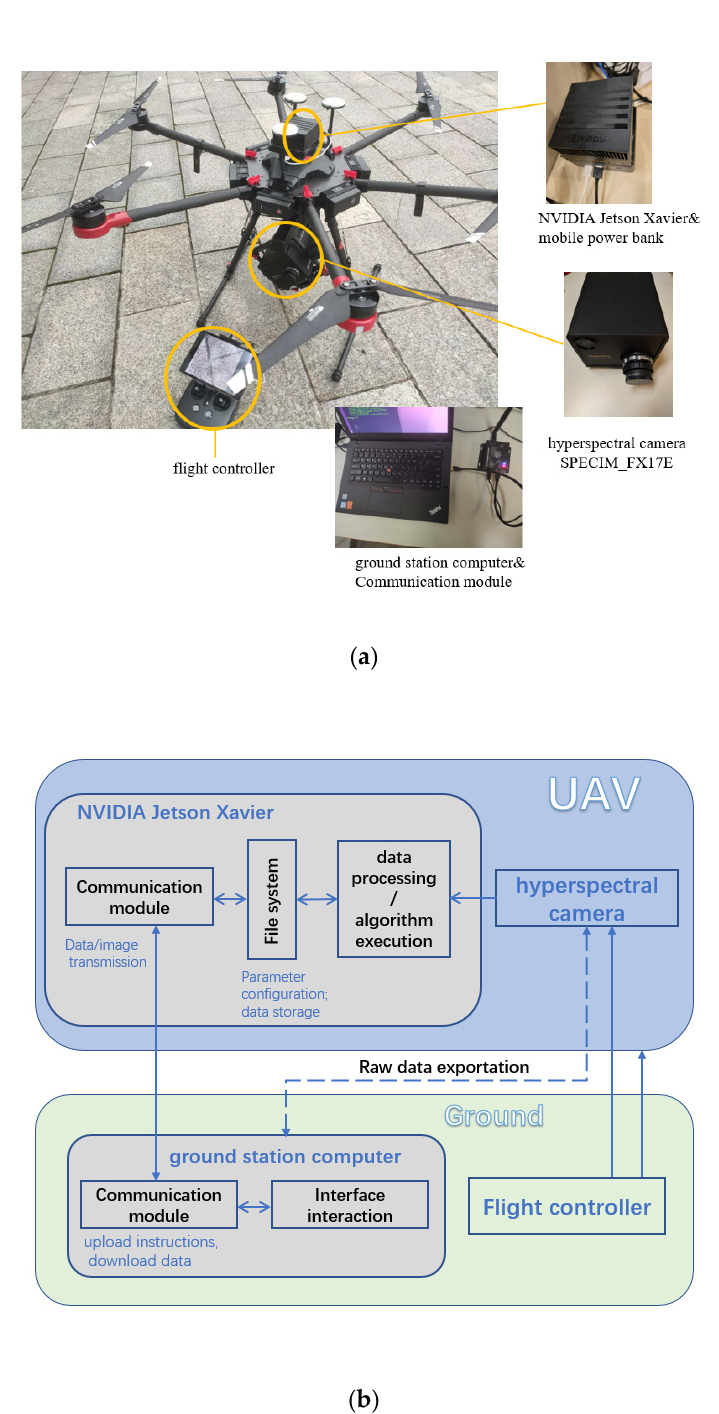
Figure 9. ( a ) The whole photoelectric platform based on UAV; ( b ) the schematic diagram of the online operation of the entire platform.